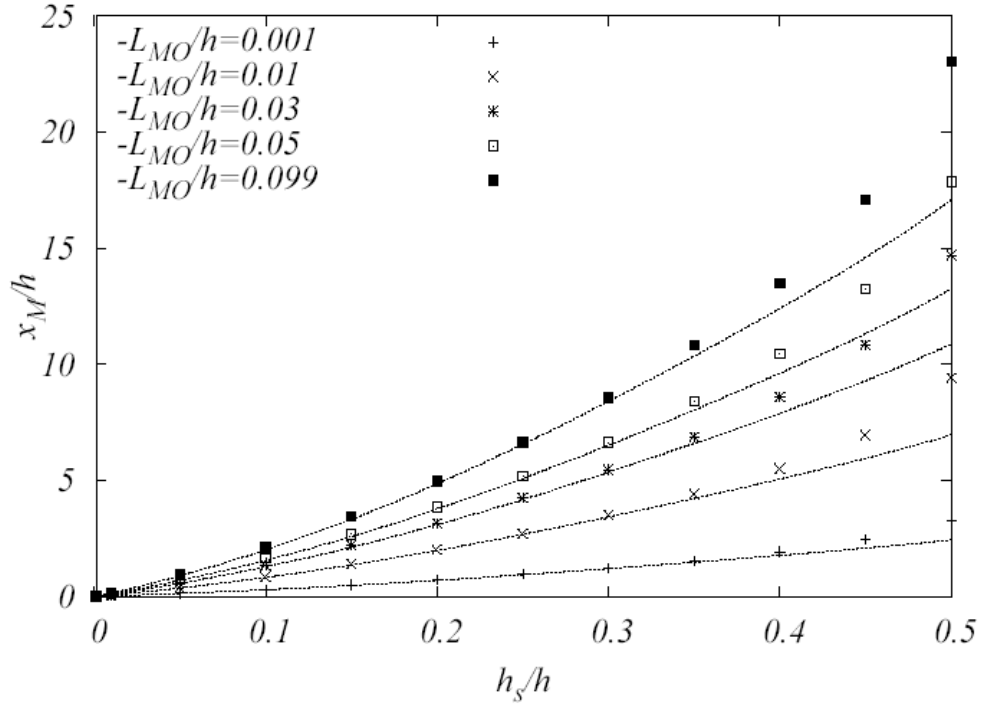
Figure 4. Position of the maximum GLC versus the source height hhh to the GILTT results, dotted lines refer to Equation (20).